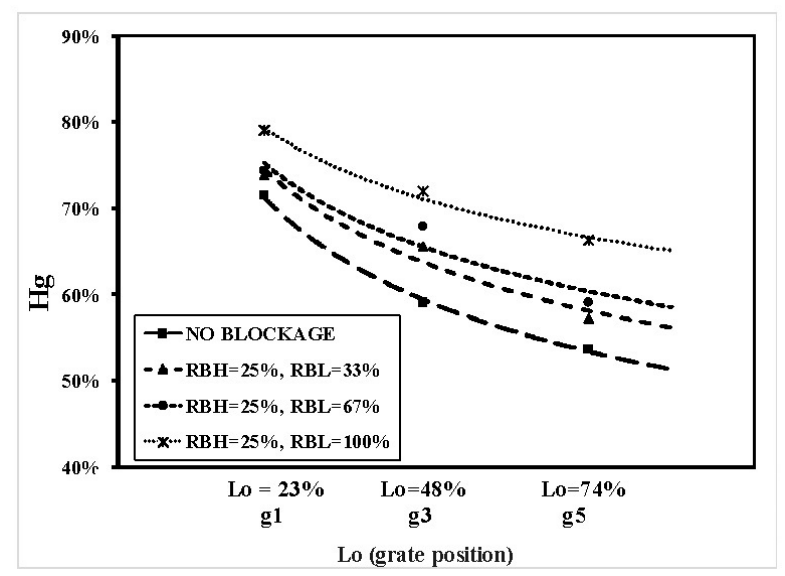
ff erent LB at HB 25% at Q = 6.00 L / sec.